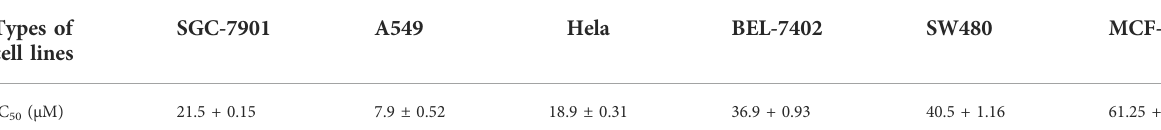
TABLE 1 IC50 values of ShtlX on selected cancer cell line. Types of cell lines